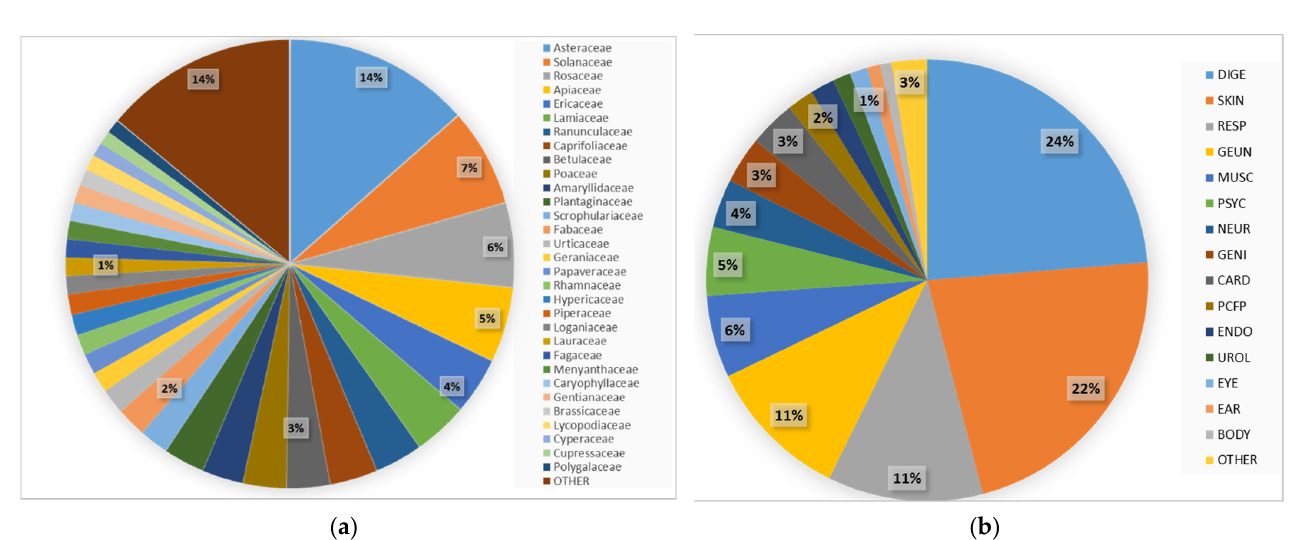
Figure 1. Proportional distribution of DUR among ( a ) plant families and ( b ) general disease categories. For abbreviations of the diseases see Table 1 below.